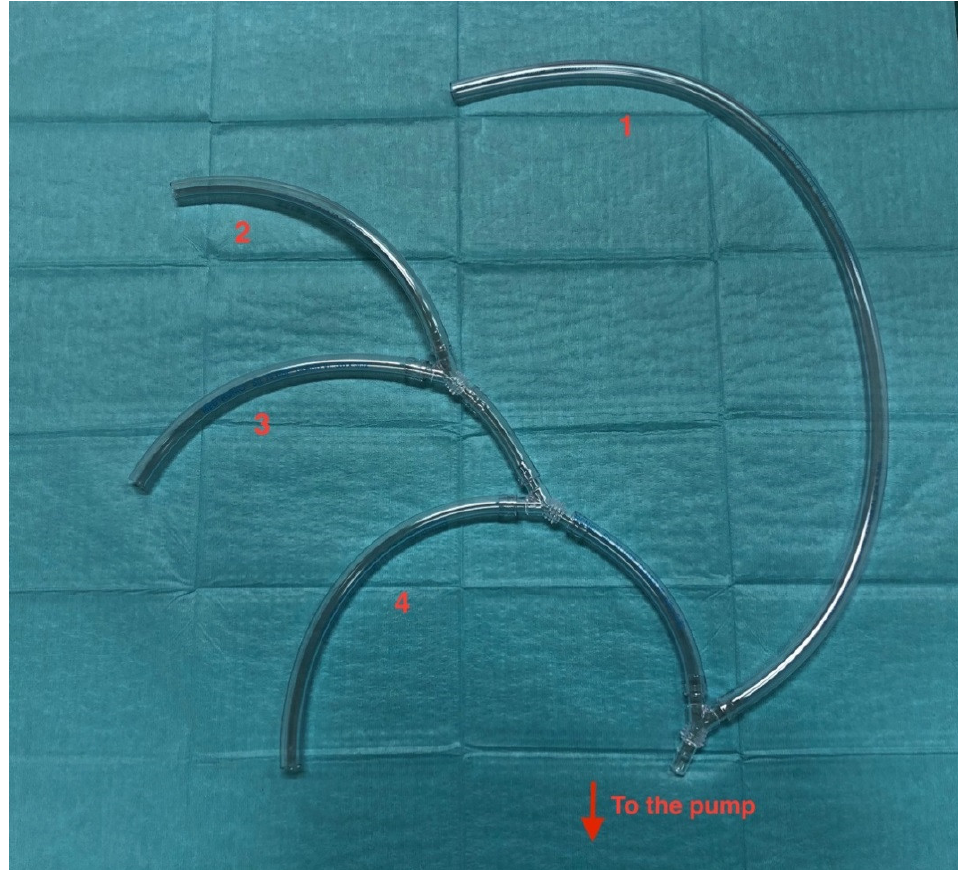
Figure 2. Home-made perfusion system driven by a single pump: 1, right intrathoracic subclavian artery perfusion (systemic perfusion); 2, left subclavian artery perfusion; 3, left carotid artery perfusion; 4, side-branch systemic perfusion [18].